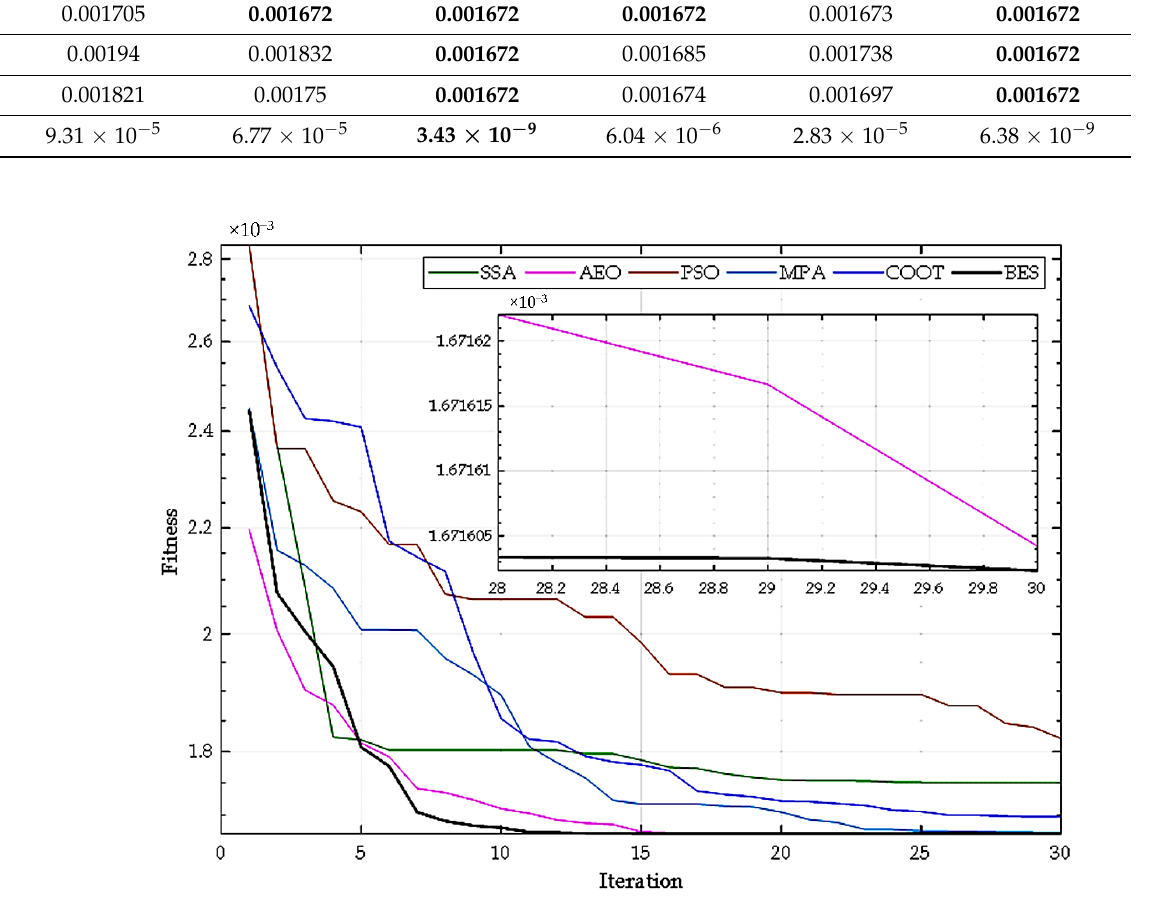
Table 5. Identification statistics for test 2.